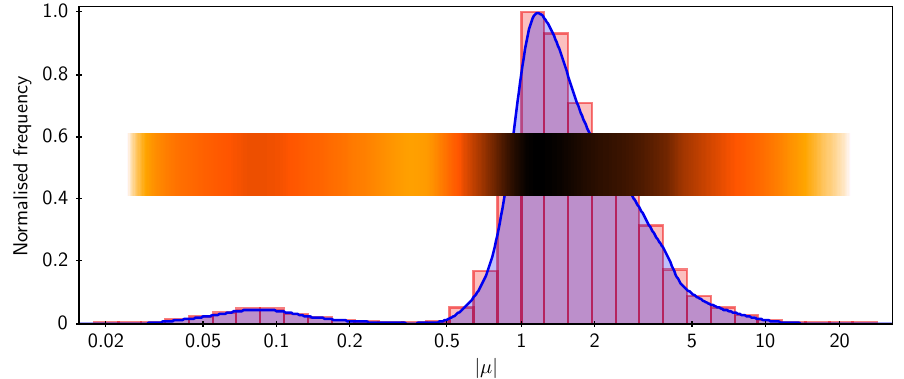
Figure 6. Some histogram-like plots. Shown here are three different representations of the same one-dimensional dataset: a traditional histogram, a Kernel Density Estimate which uses a smoothing kernel to avoid the quantisation implied by histogram binning, and a “densogram” that represents point density using a colour